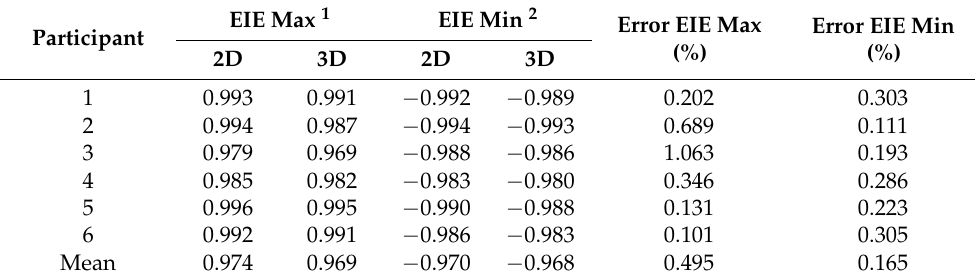
Table 7. Differences and relative error between EIE 2D and EIE 3D .